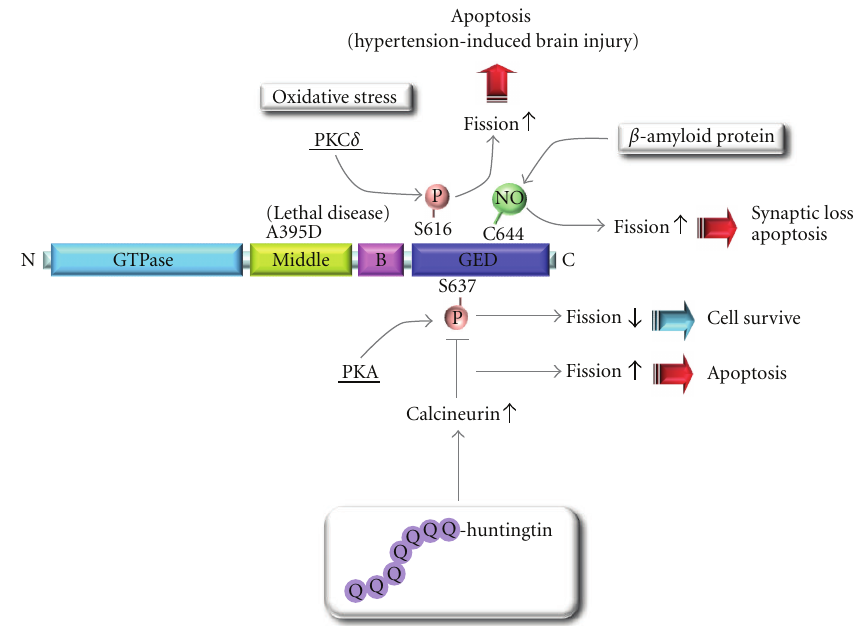
Figure 1: Domain structure of Drp1 and schematic view of the regulation of Drp1 by posttranslational modifications. Drp1 activity is regulated by various posttranslational modifications and changes in these modifications are related to several disorders. Under oxidative stress, protein kinase C δ (PKC δ ) phosphorylates Drp1 at Ser616 in the GED domain. Drp1 is recruited to mitochondria and stimulates mitochondrial fission, leading to apoptosis in hypertension-induced brain. Cyclic-AMP-dependent protein kinase (PKA) phosphorylates Drp1 at Ser637 in the GED domain. This reaction releases Drp1 from mitochondria to the cytosol, leading to mitochondrial elongation and suppression of apoptosis vulnerability of the cells. Calcineurin dephosphorylates Drp1 at Ser637 and promotes mitochondrial fragmentation and cell vulnerability to apoptosis. Polyglutamine expansion in huntingtin protein activates calcineurin and increases mitochondrial frag- mentation and cell vulnerability to apoptosis. β -Amyloid protein increases S-nitrosylation of Drp1 at Cys644 in the GED domain to trigger mitochondrial fission by activating GTPase, thereby causing synaptic loss. All amino acid numbering is based on the human Drp1 splice variant 1